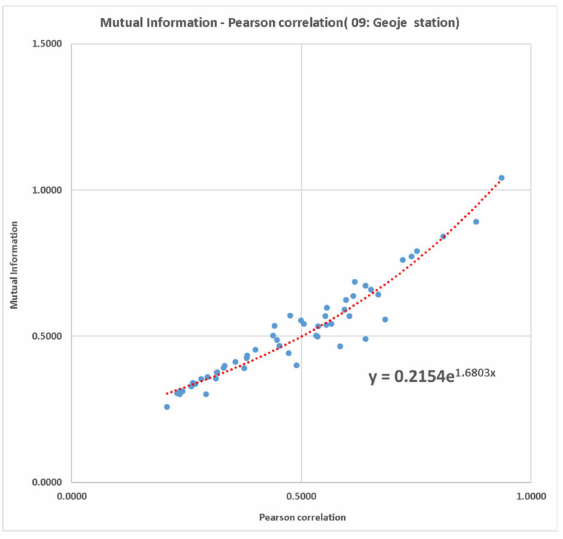
Figure 3. Mutual information—Pearson correlation graph (09: Geoje): The X -axis is the Pearson coe ffi cient and the Y -axis is the mutual information. In the graph, the two axes have di ff erent ranges ( X : 0.0–1.0, Y :